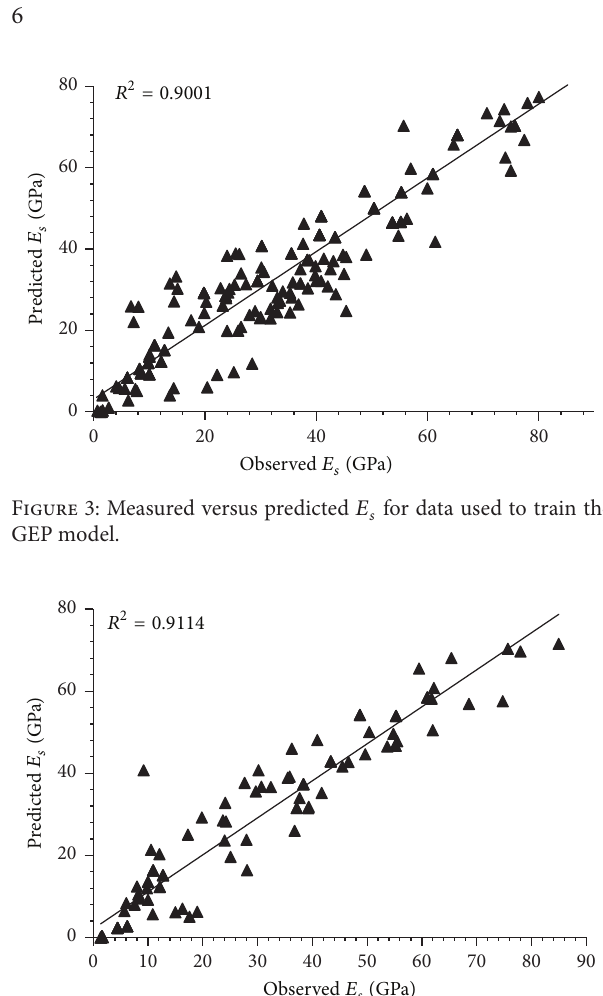
Figure 4: Measured versus predicted 𝐸 𝑠 for data used to validate the GEP model.